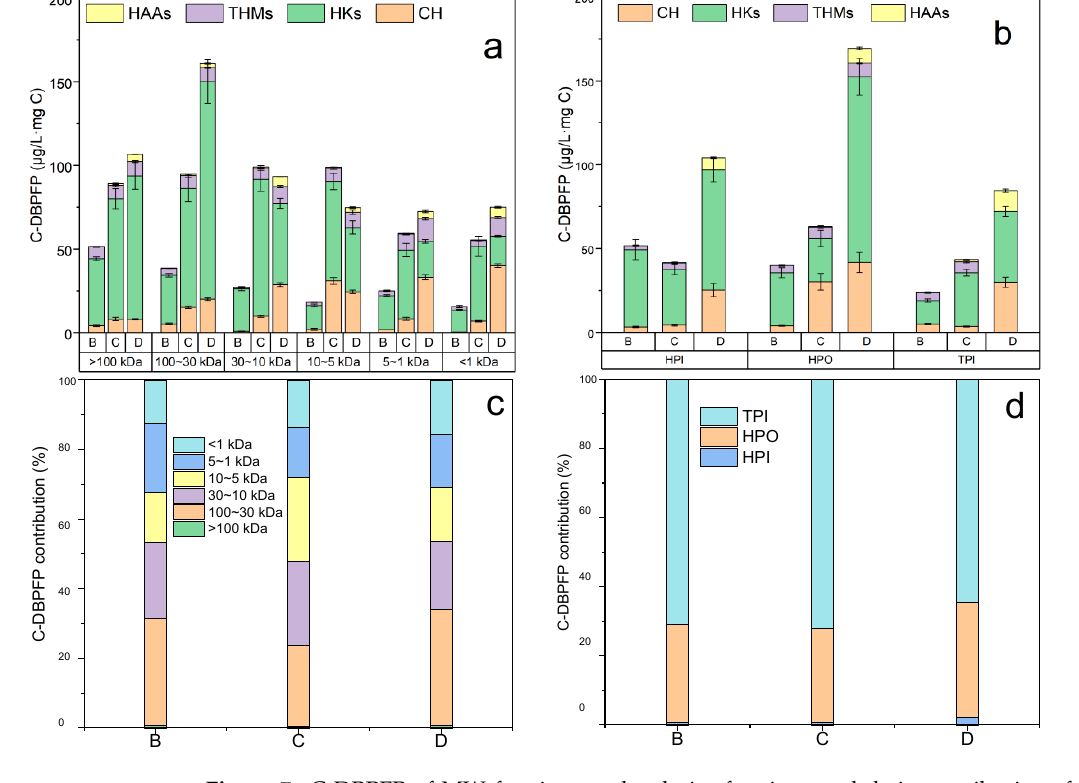
Figure 7. C-DBPFP of MW fractions and polarity fractions and their contributions for diffident fractions after chlorination ( a ) C-DBPFP of MW fractions; ( b ) C-DBPFP of polarity fractions; ( c ) C- DBPFP contribution of MW fractions; ( d ) C-DBPFP contribution of polarity fractions) (B: AGC effluent, C: AAO effluent, and D: MBR effluent).